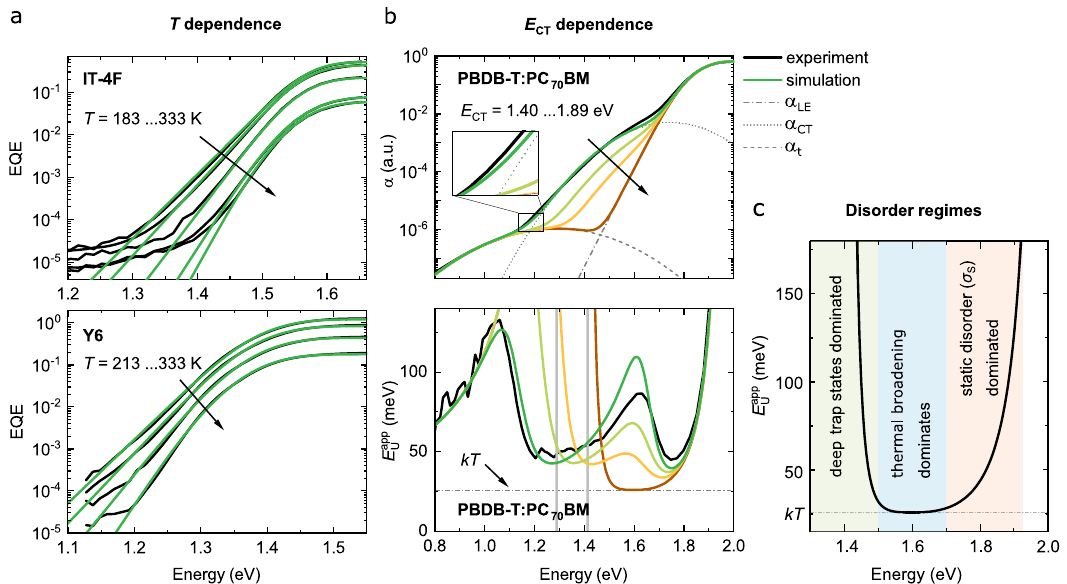
Fig. 4 The sub-bandgap EQE as a function of T and E CT . a , Experimental (black lines) and simulated (green lines) sub-gap EQE spectra of IT-4F and Y6. b , The line-shape of the experimental sub-gap EQE of PBDB-T:PC 70 BM can be described as the sum of LE absorption, CT state absorption, and trap state absorption: α ¼ α LE þ α CT þ α t ; with α LE given by Eq. 3 ( E opt ¼ 1.89 eV, σ s ¼ 60 meV), while α CT and α t are determined from their respective Gaussian fi ts. (cid:2) E ! kT between 1.5 to 1.7 eV. c , In the experiment, E app is well above kT , since E 0 : 3eV : Increasing E (see Eq. 5) in the simulation results in E app opt CT > CT U U Schematic representation of the disorder regimes dominating α in the absence of CT absorption comprising (i) static disorder σ s close to the band edge, (ii) ¼ kT , and (iii) deep trap state absorption well below the thermal broadening, where E app U